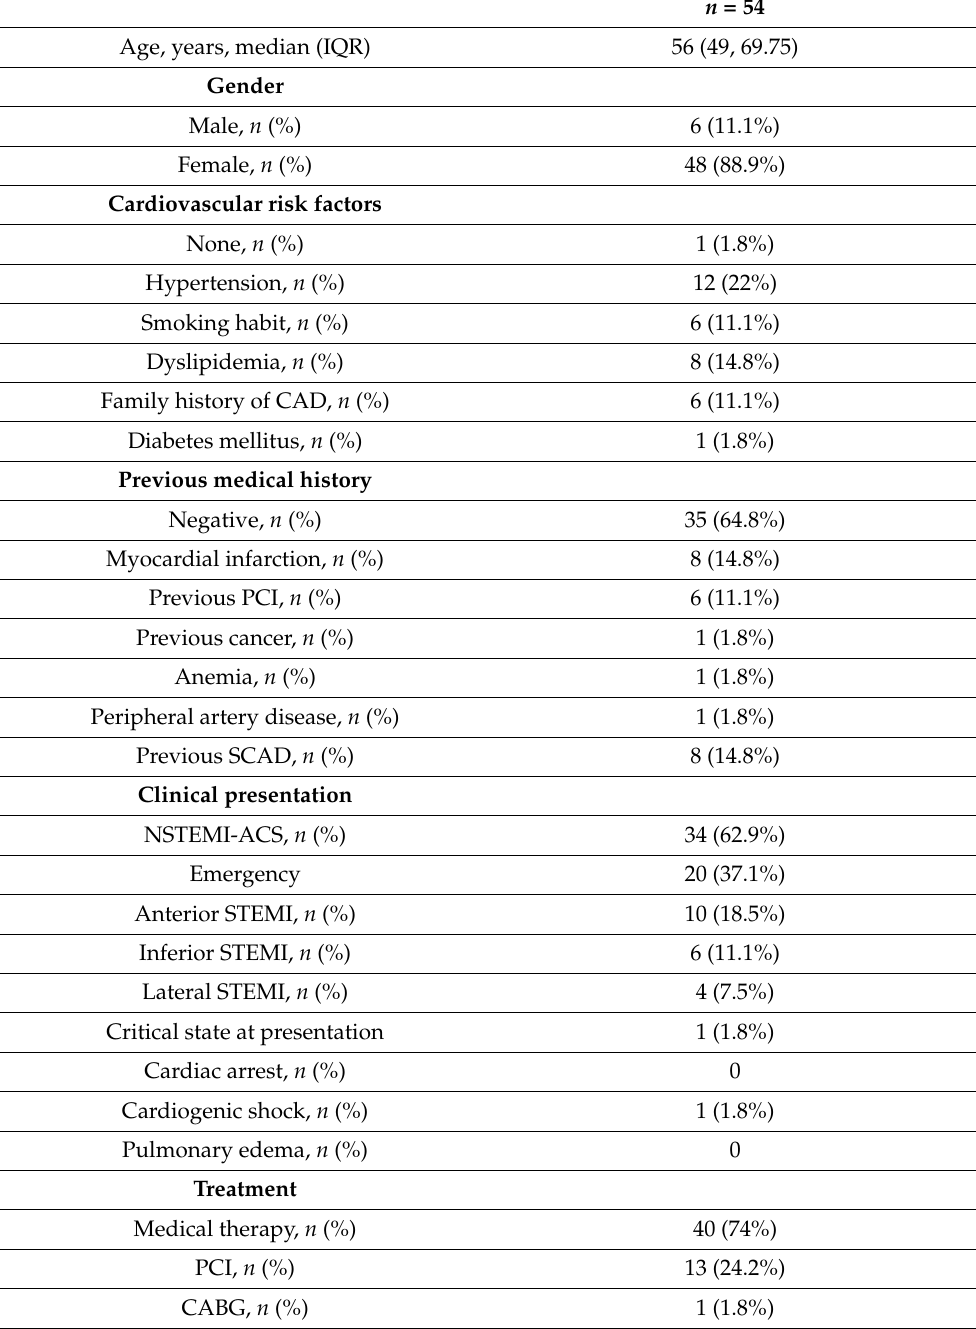
Table 1. Monzino’s SCAD dataset (January 2007–November